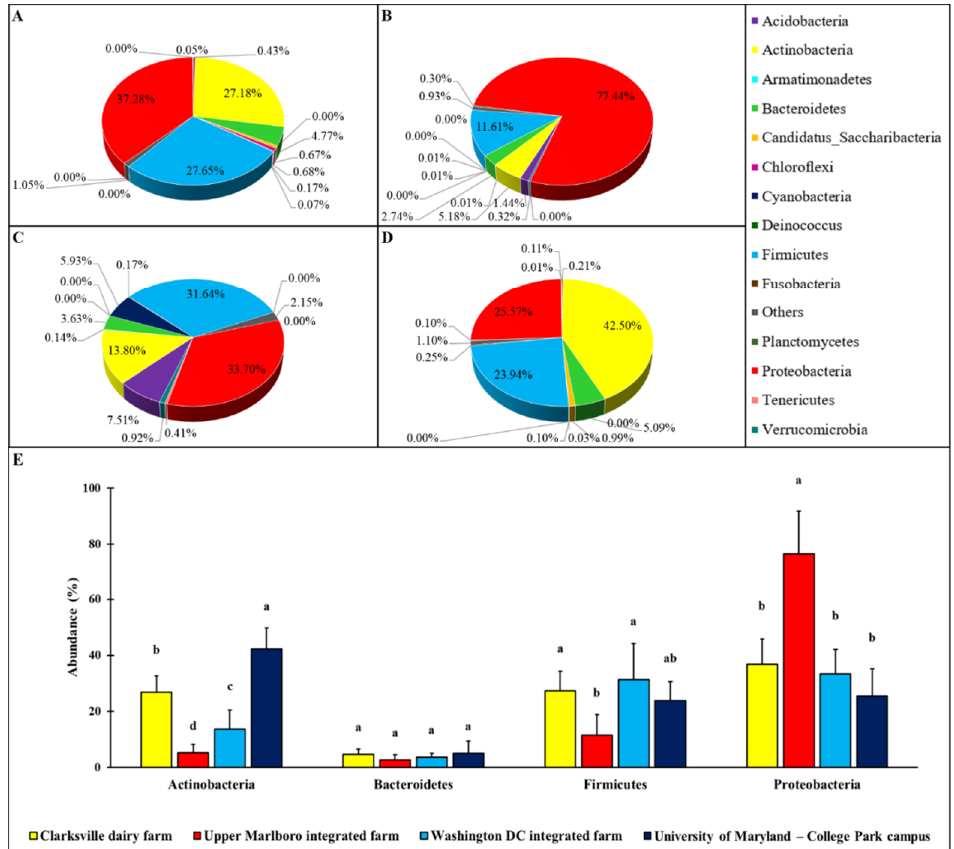
Figure 1. Relative percentage of the phylum level abundance in forearm skin microflora. The relative skin microbial abundance in the investigated individuals from the dairy farm in Clarksville ( A ), the integrated farm in Upper Marlboro ( B ) and Washington DC ( C ), and University of Maryland—College Park campus ( D ) was analyzed and compared at the phylum level. The top four phyla across each group are shown in ( E ). The a, b, c, and d indicate significant differences based on ANCOM.